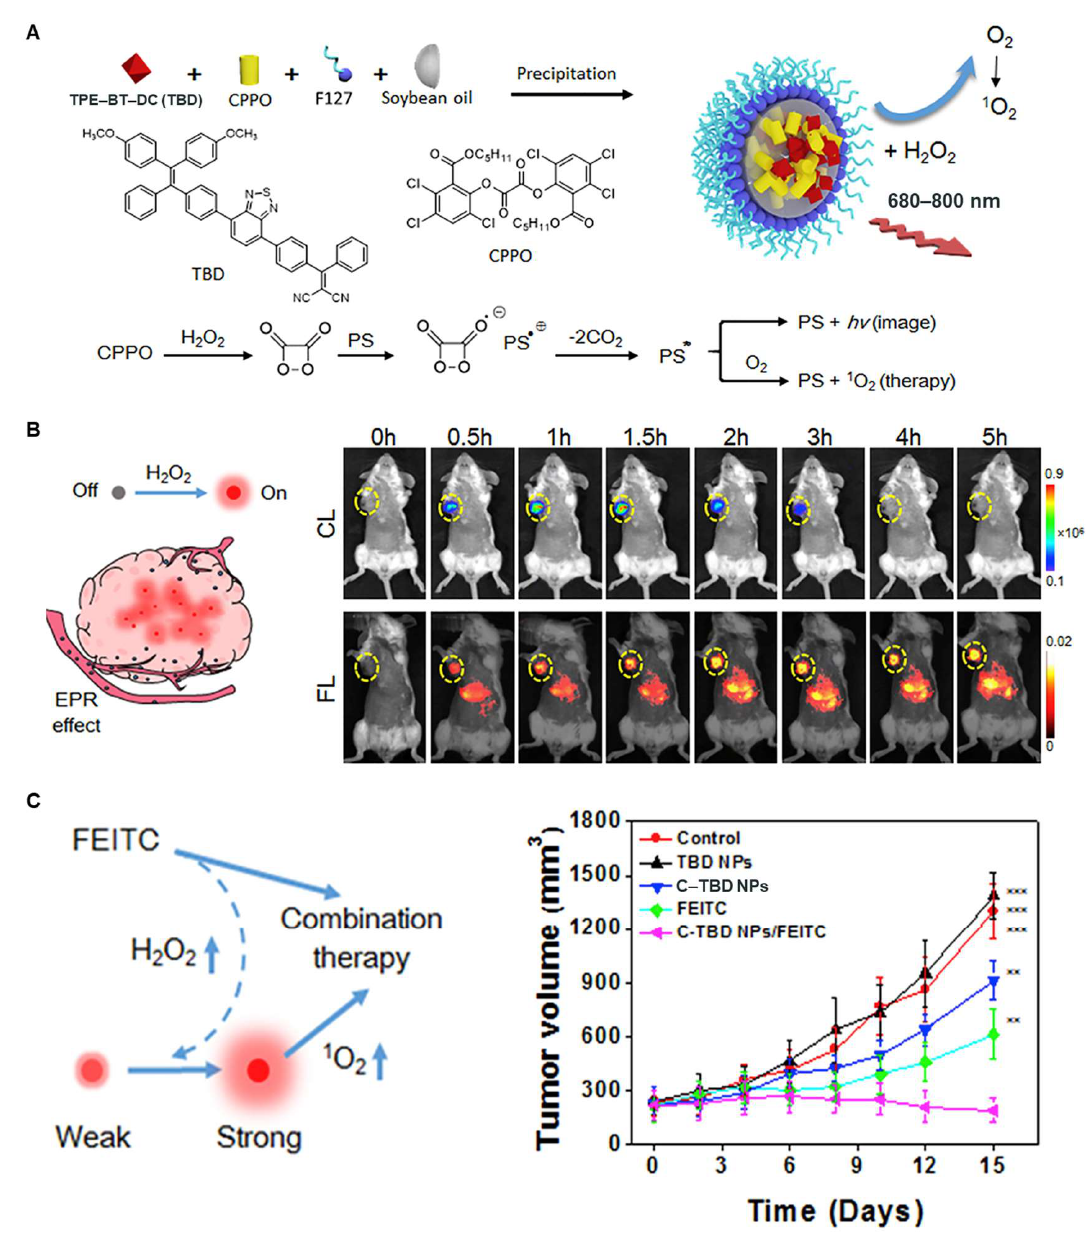
Figure 5. ( A ) Illustration of the preparation of C–TBD NPs and NIR imaging principle and PDT in the presence of hydrogen peroxide. ( B ) The tumor images of chemiluminescence and fluorescence. ( C ) The antitumor effects of C-TBD NPs in coordination with FEITC [43]. Reprinted with permission from Ref [43] Copyright 2017 Elsevier, Amsterdam, The Netherlands.